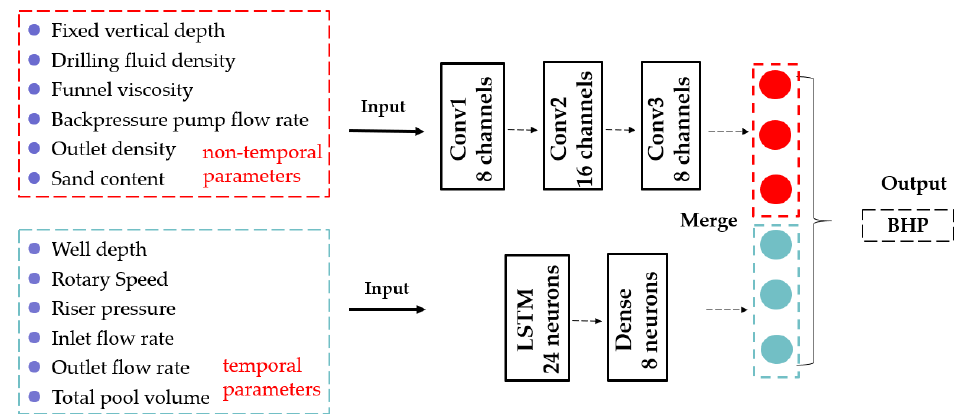
Figure 8. CNN-LSTM parallel network internal detailed structure.